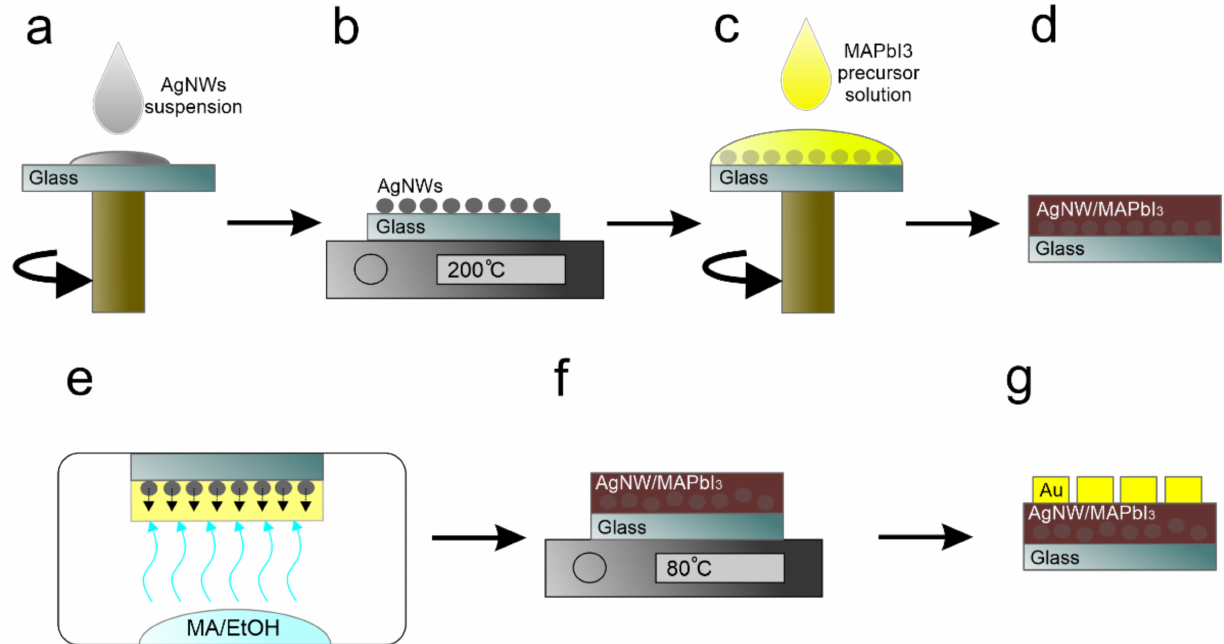
Figure 2. Schematic representation of fabrication of MSM PPDs. ( a ) Deposition of AgNW network layer on glass substrate; ( b ) Thermal annealing of AgNW network layer; ( c ) Deposition of MAPbI 3 layer onto AgNW network layer; ( d ) Schematic cross-section of AgNW/MAPbI 3 layer; ( e ) Liquefying of MAPbI 3 layer by MA vapor treatment; ( f ) MAPbI 3 layer with embedded AgNW network layer; ( g ) Schematic cross-section view of complete MSM